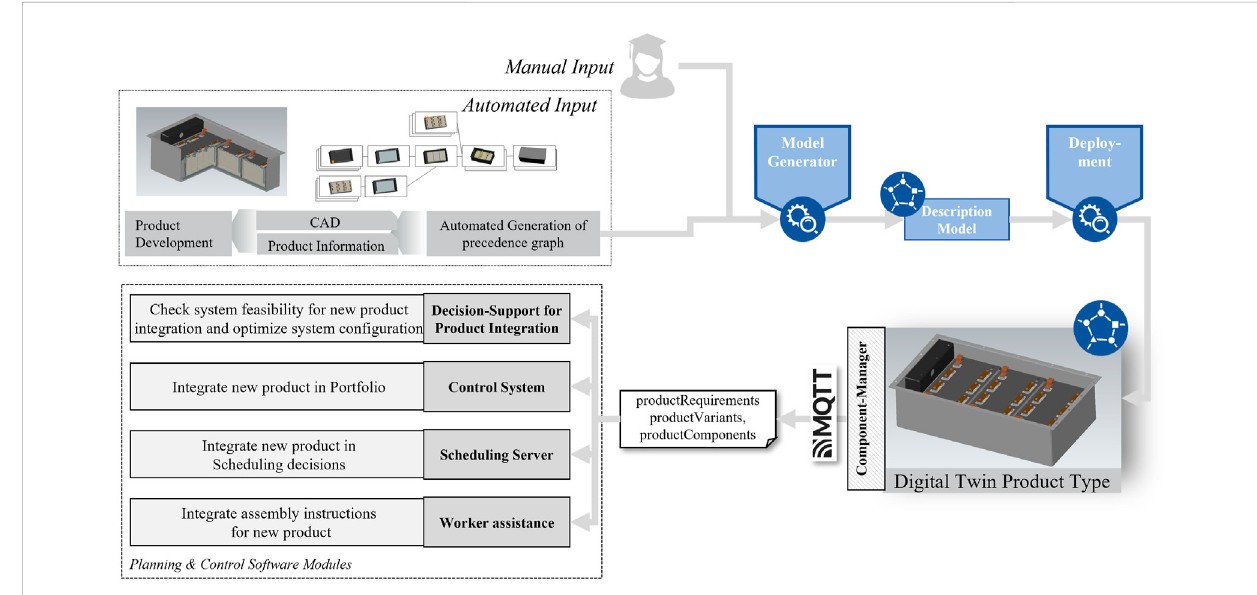
FIGURE 8 Work fl ow of integrating new product variants into a line-less assembly system using the Digital Twin